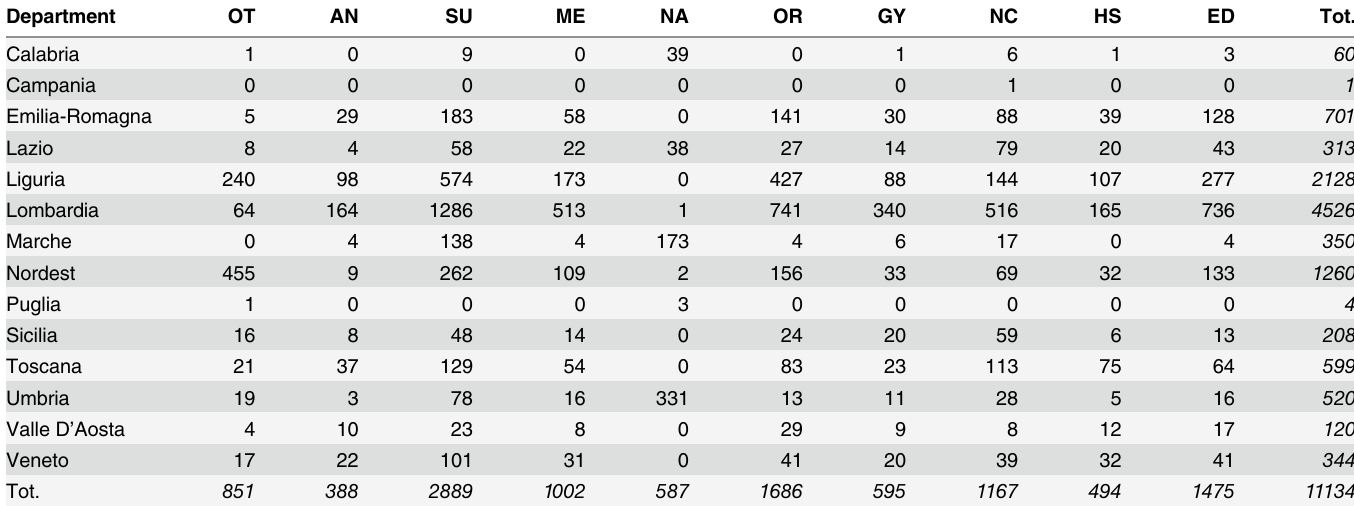
Table 12. Number of claims by department (columns) and geographic region (rows), as used in the analysis of the monetary amounts related to injuries ’ claims. Department